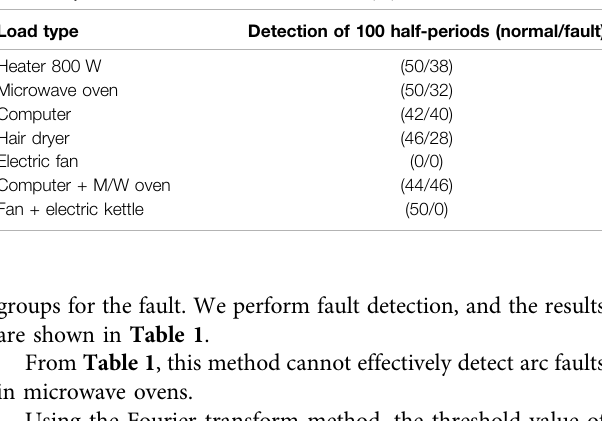
TABLE 4 | Statistics of arc fault detection results ( d 4